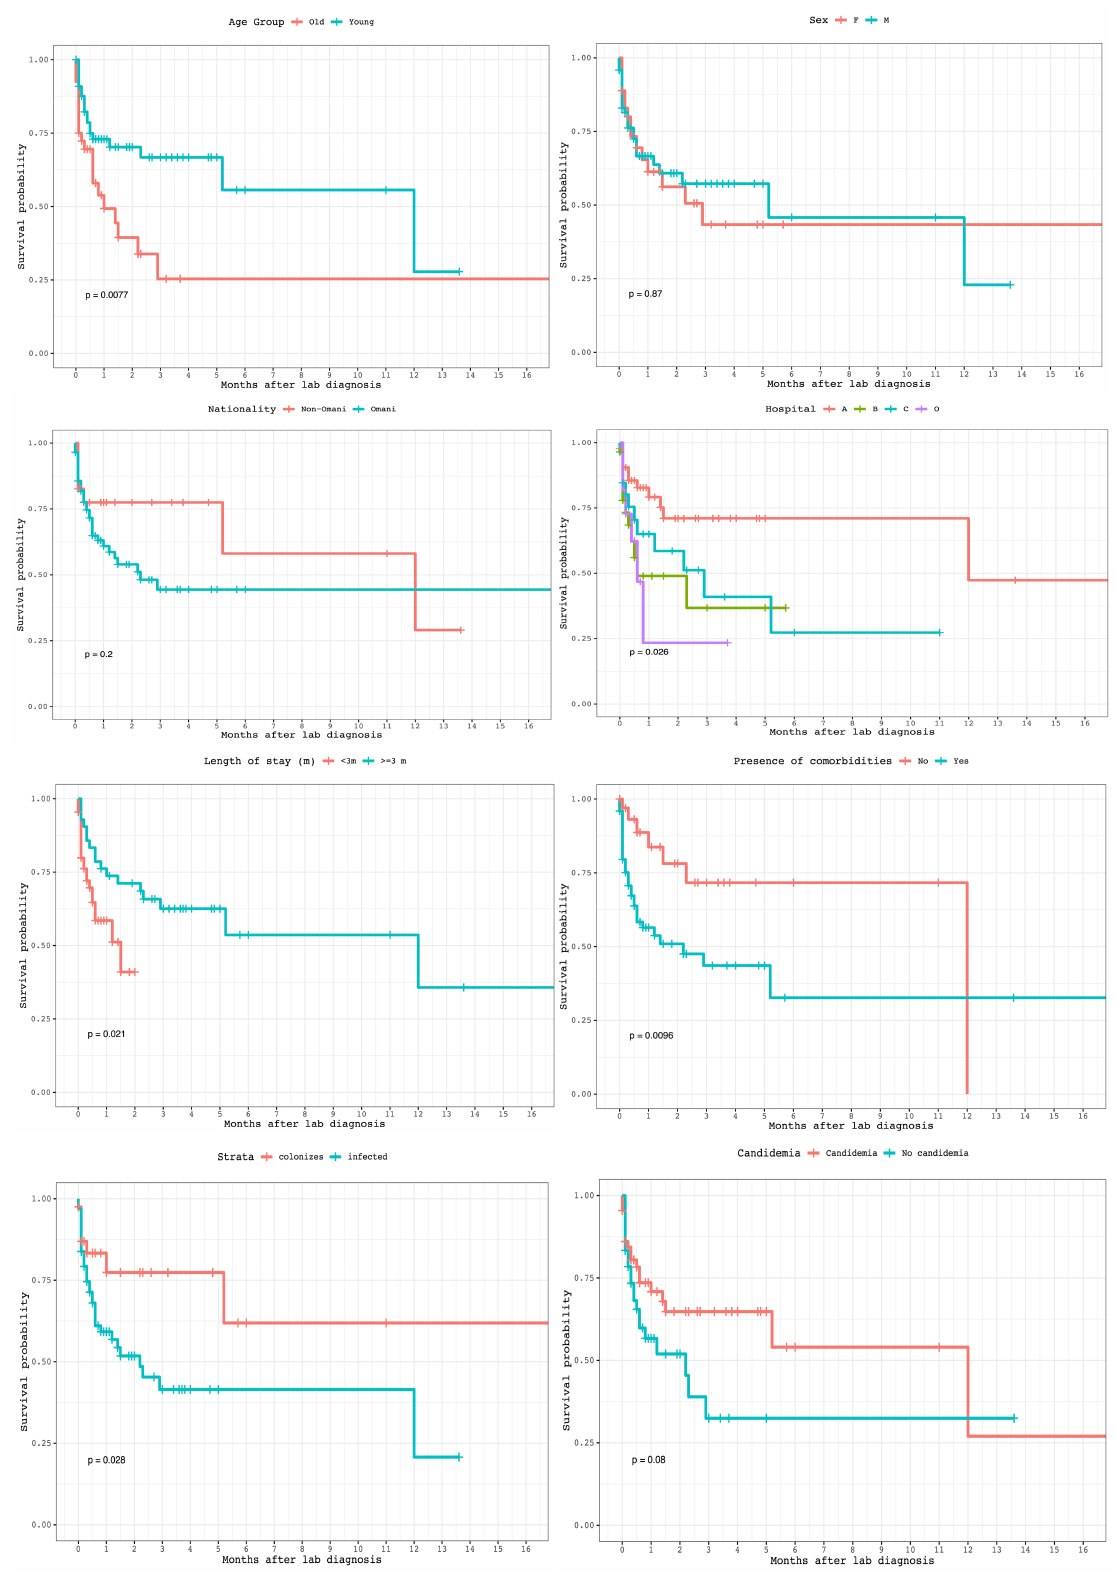
Figure 2. Kaplan–Meier survival analyses of age, sex, nationality, length of stay, presence of comorbidities, hospital where patients were admitted, candidemia, and colonization vs.